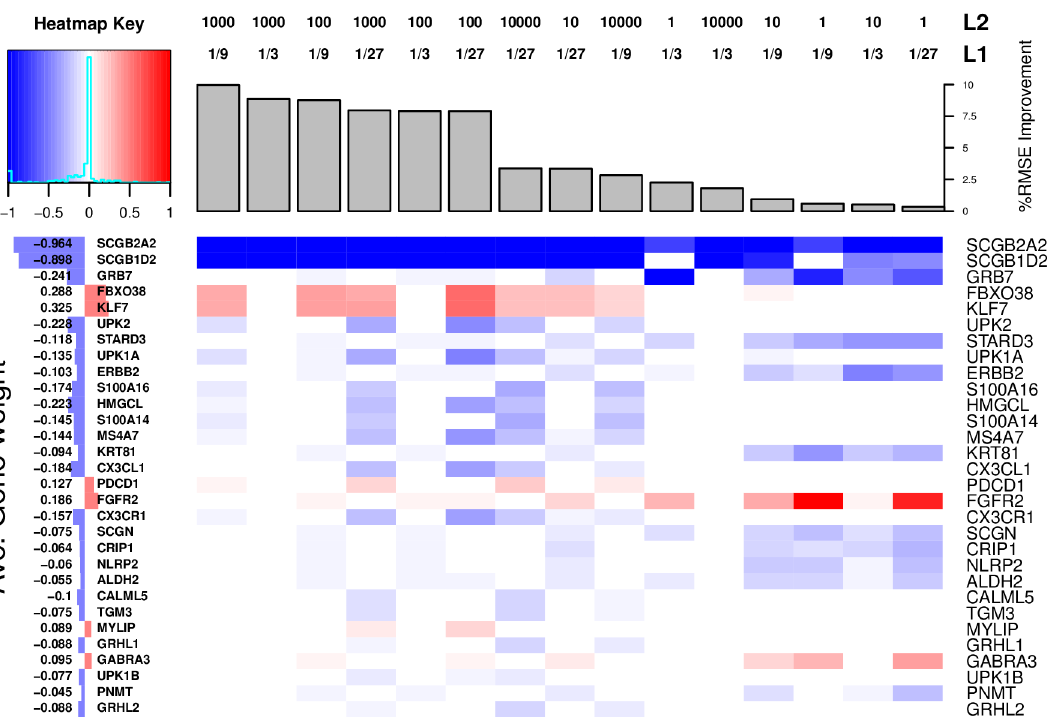
Fig 5. Models for sensitivity of Gray cell lines to BIBW2992 learned by GELnets. We present the model weights for the top 30 genes (see text) as they change across the different values of the λ 1 and λ 2 meta-parameters. Higher positive (red) weights are associated with resistance, while higher negative (blue) weights are associated with sensitivity. The models are sorted by their % RMSE improvement over the corresponding Elastic Net models. The barplot on the left displays the average weight of each gene across all meta-parameter values where the weight is not zero.